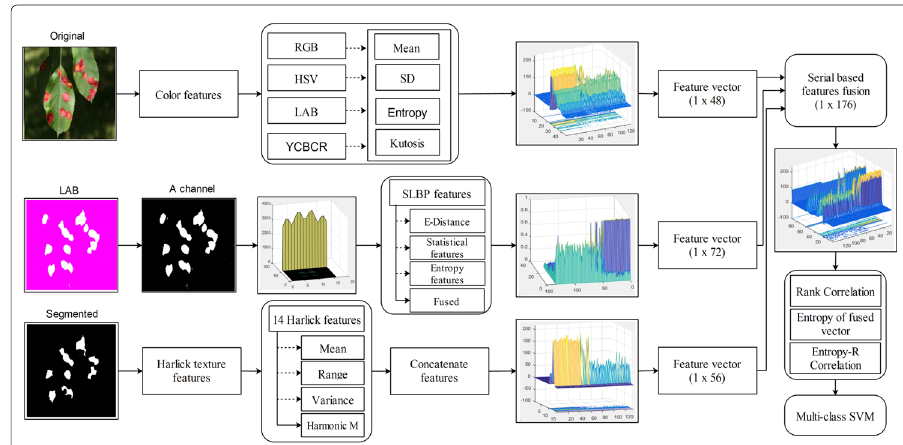
Fig. 13 An system architecture of proposed feature extraction and